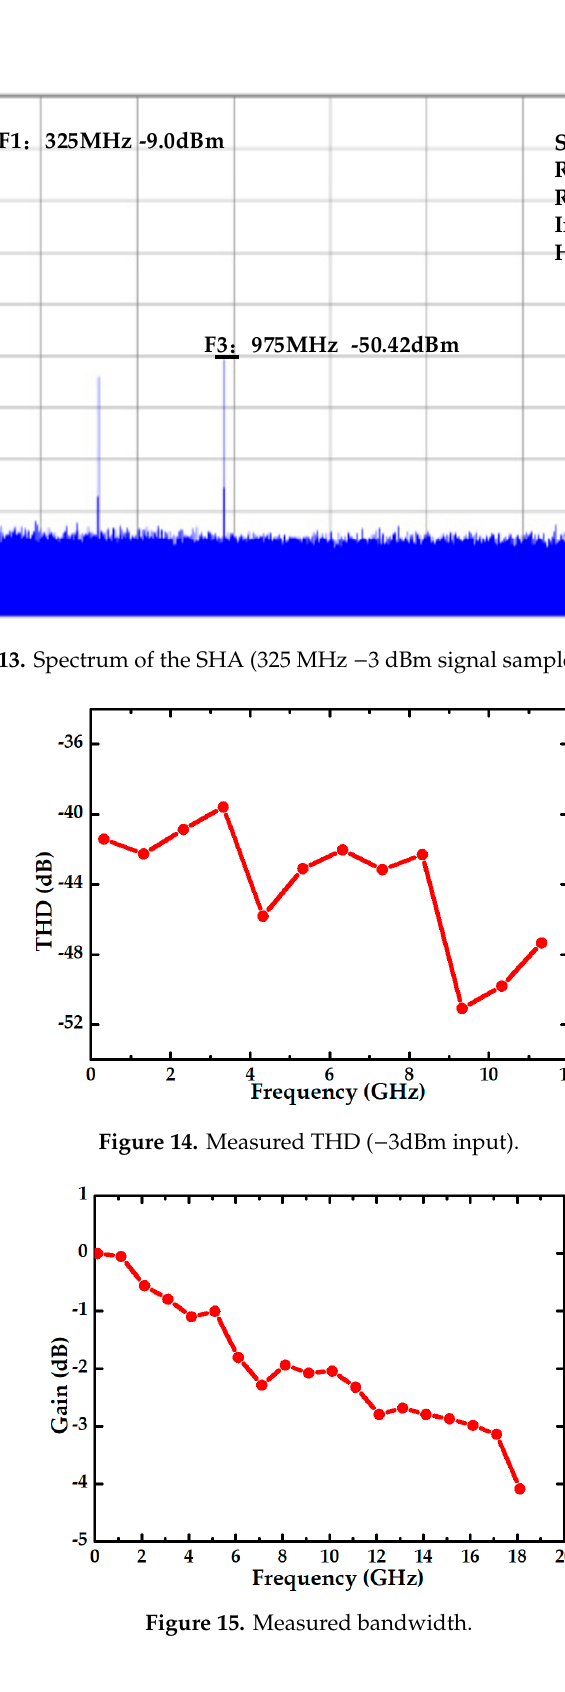
Figure 15. Measured bandwidth.